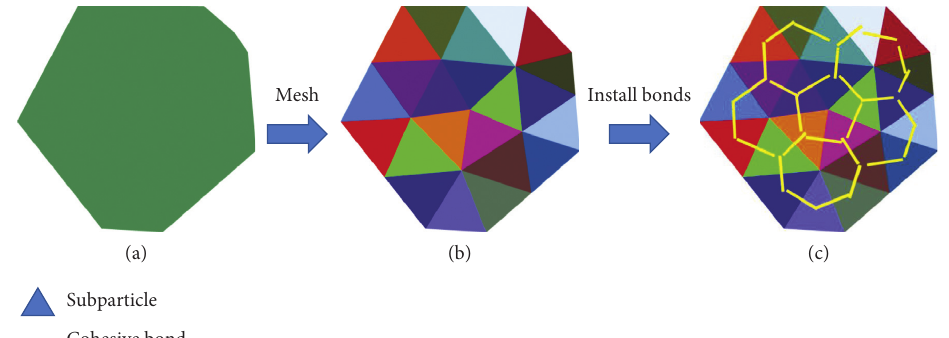
Figure 3: Modeling procedure of rockfill particles, considering the shape and breakage. (a) Polygon block; (b) assembly of subparticles; (c) breakable cluster.